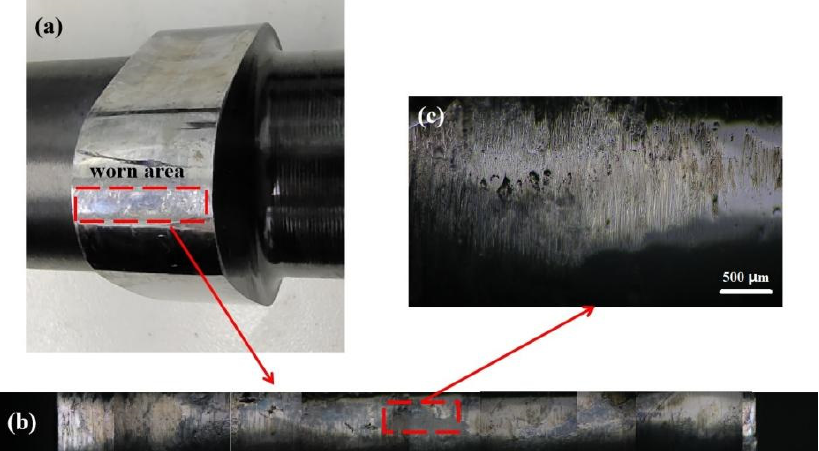
Figure 4. The worn area of the cam: ( a ) macro photo, ( b ) surface morphology of stitching after continuous shooting with optical microscope, ( c ) amplification of the middle position of the wear area.